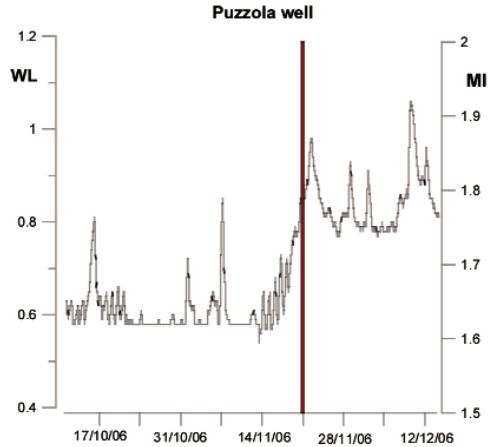
Fig. 13. Temporal variations of the water level at the Bove spring during October-December 2006 observ- ative interval. One earthquake occurred within a 20 km-radius area, however because of the low energy is not considered as responsible for the observed modifications (see